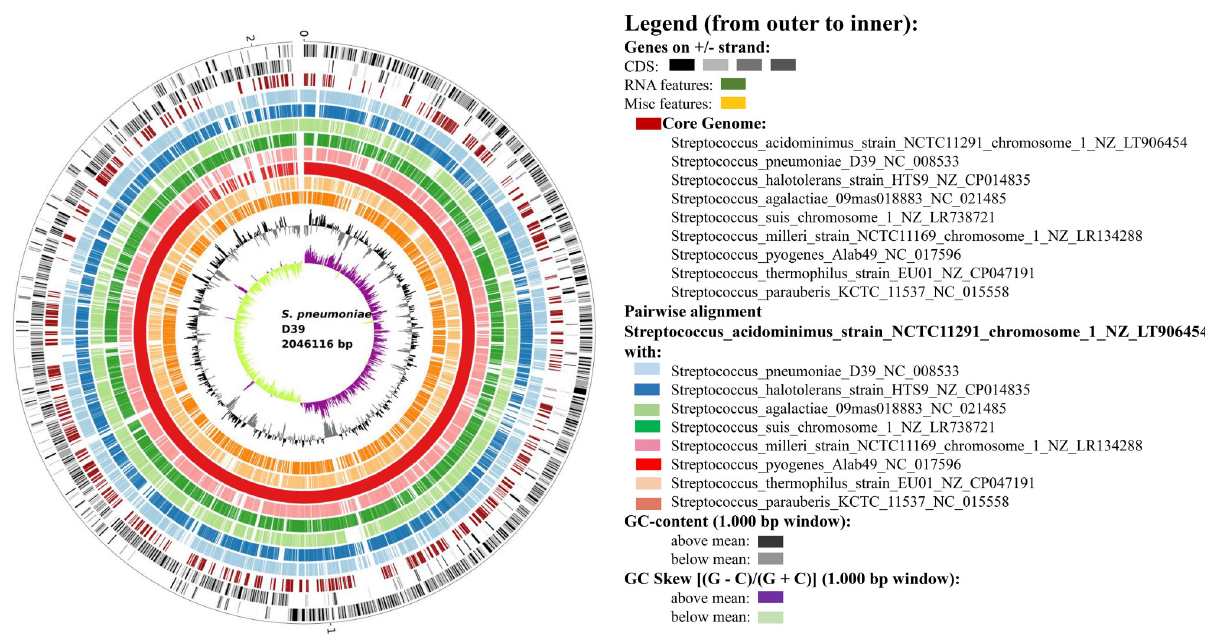
Fig 2. Circular representation of the S . pneumoniae genome and related species. The brown bar of the circular plot represents the core genes.